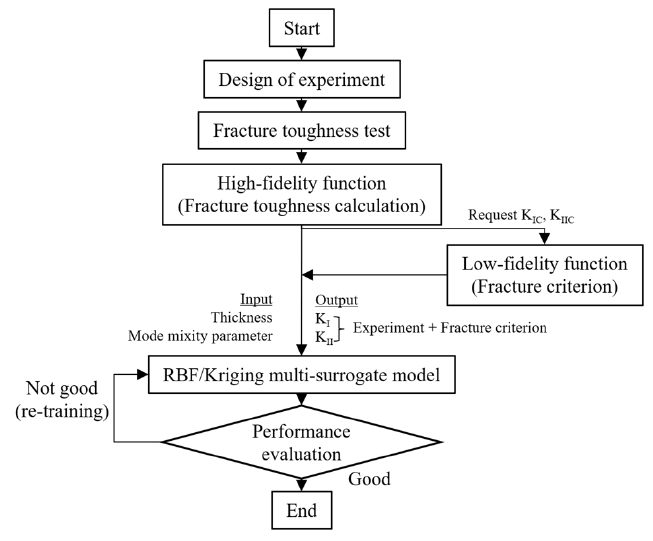
Figure 8. The modeling process of the multi-fidelity surrogate model.